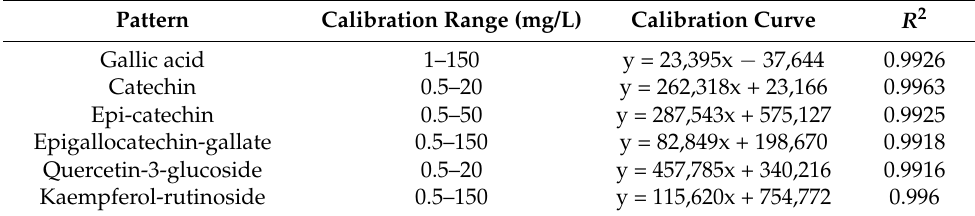
Table 3. Calibration curves used in the quantification of phenolic compounds. Pattern Calibration Range (mg/L) Calibration Curve R 2 Gallic acid 1–150 y = 23,395x − 37,644 0.9926 Catechin 0.5–20 y = 262,318x + 23,166 0.9963